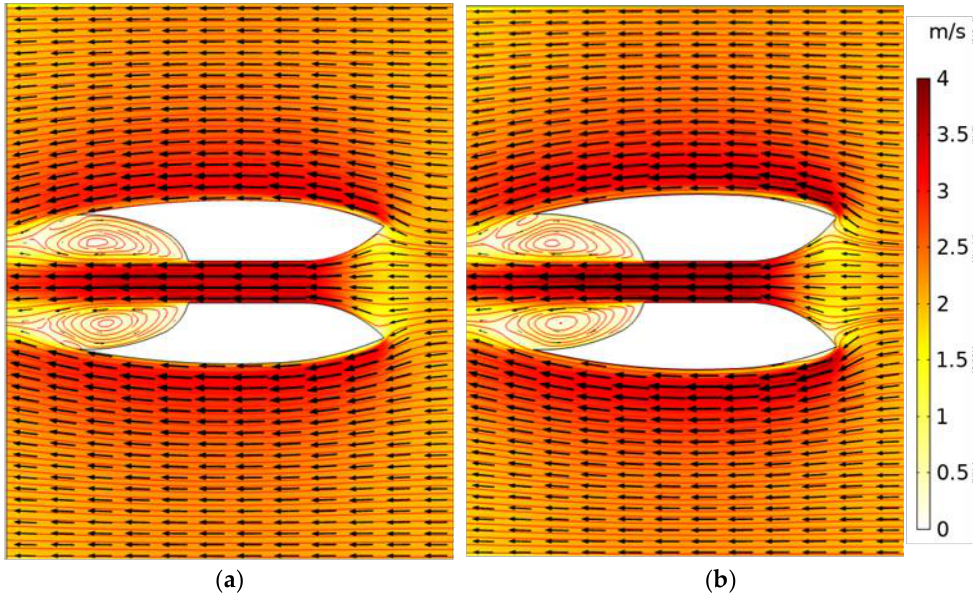
Figure 14. Flow velocity distribution by 2D FEA for duct scale models D3 ( a ) and D4 ( b ). The presented distributions refer to a Dirichlet boundary condition, with a flow ve- locity normal to the right (inlet) and left (outlet) limit side boundaries of 𝑢 𝑛 = 2 m s −1 (4 knots)